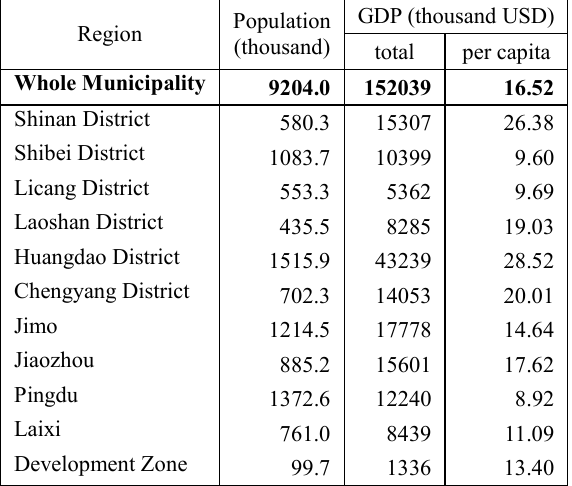
Table 1. Population and economy of Qingdao (Qingdao